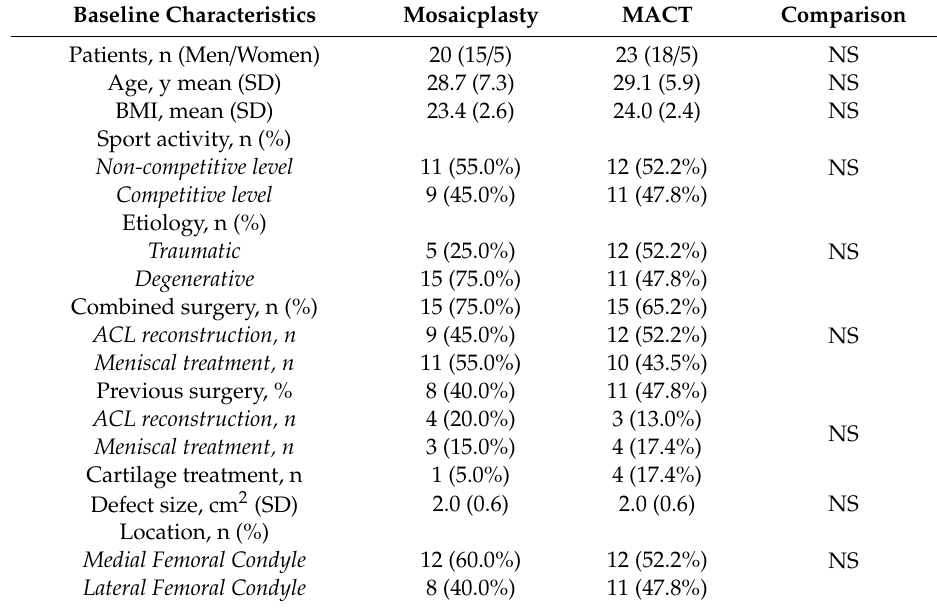
Table 1. Comparison of patient and lesion characteristics in the two